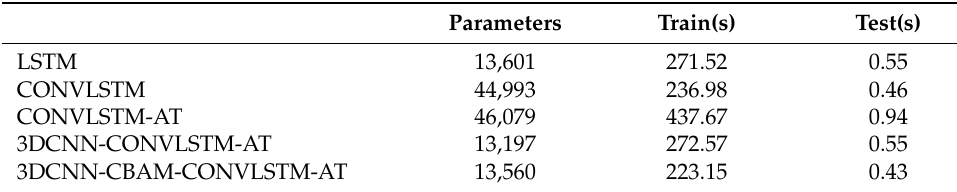
Table 2. The number of network parameters and training time for each model. Parameters